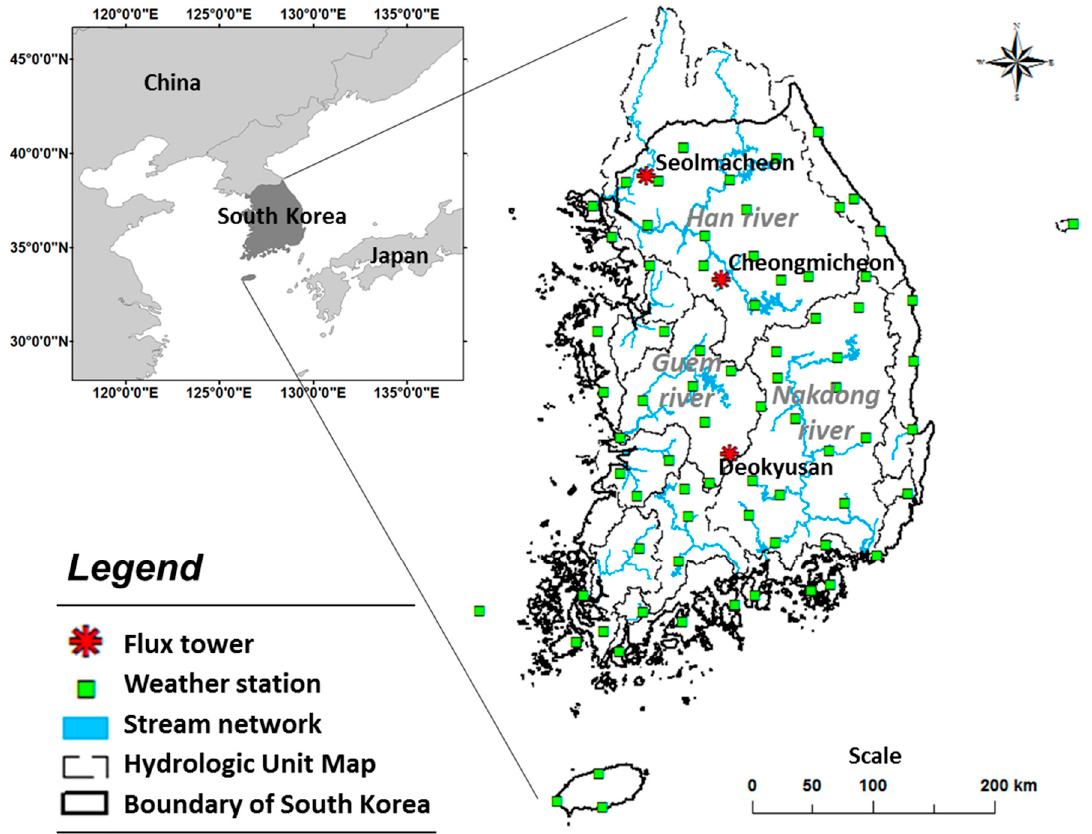
Figure 2. Location of the weather stations and flux towers in South Korea.